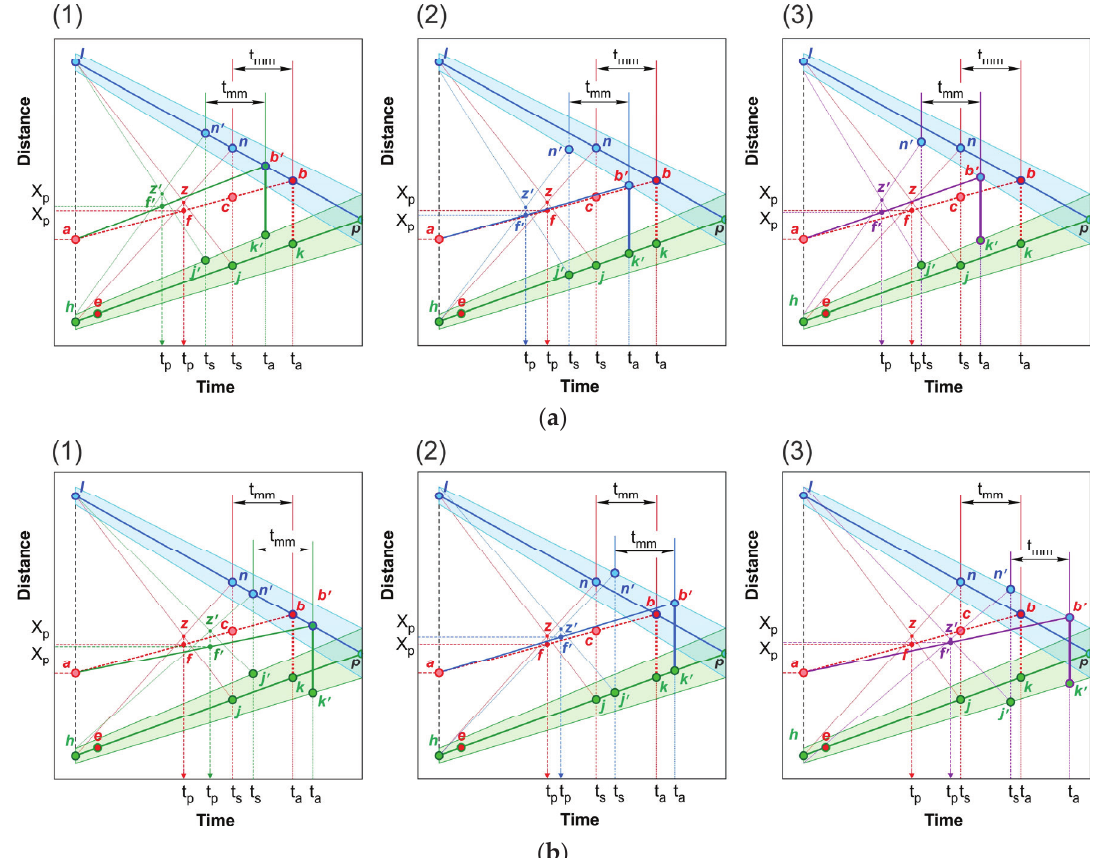
Figure 7. Influence of threshold values of speed fluctuations on the prediction reliability: ( a ) Increase in speeds of opposing and impeding vehicles (Cases 1-3); ( b ) decrease in speeds of opposing and impeding vehicles (Cases 1-3).